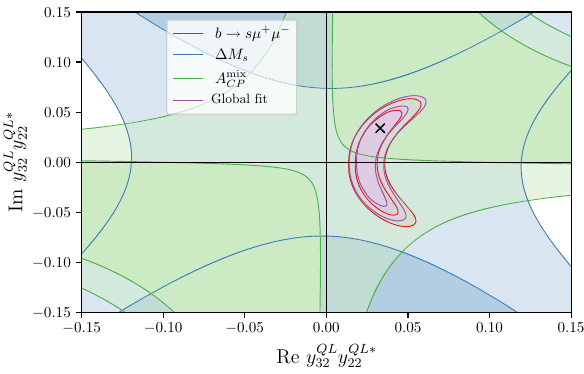
Fig. 6 Fit on S 3 leptoquark parameter space in the complex y QL plane for the best fit leptoquark mass M S